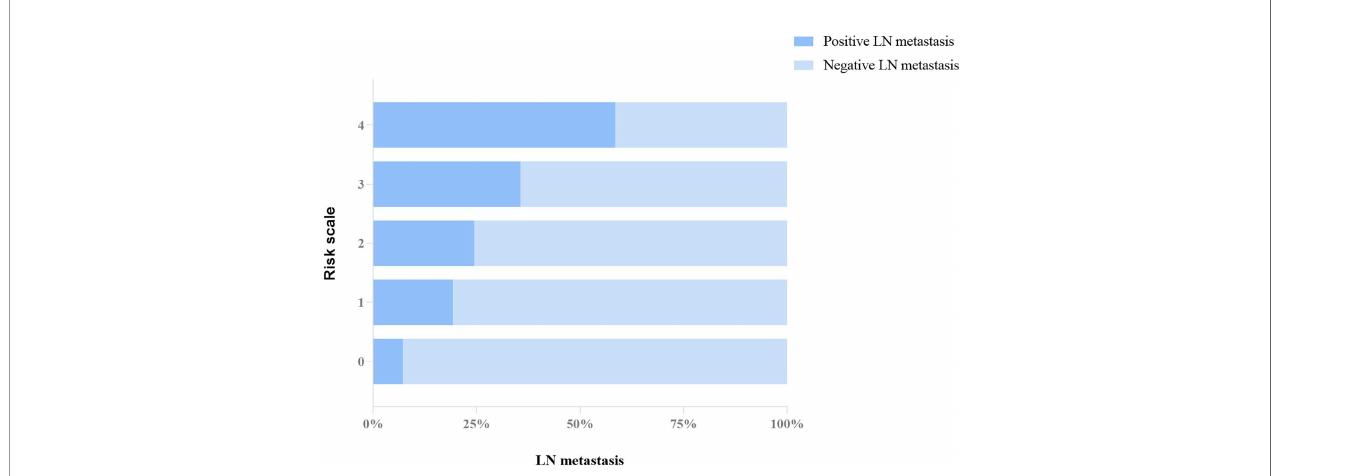
FIGURE 3 | Proportion distribution of positive and negative LN metastasis in each grade of the risk system.